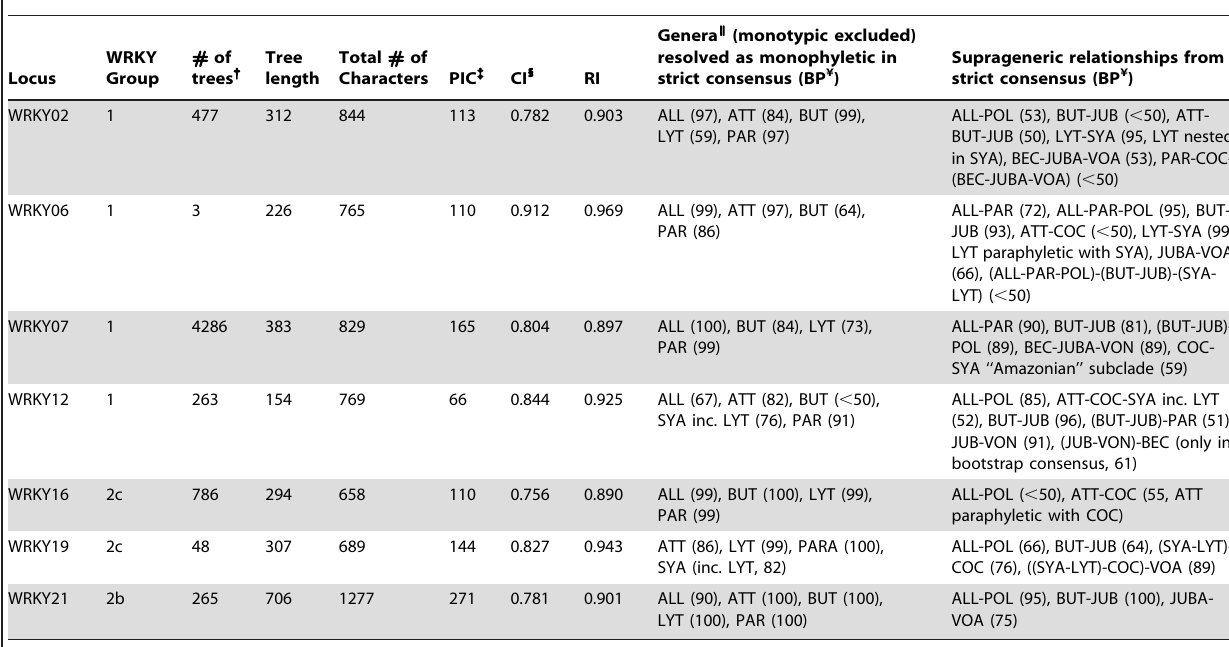
Table 1. Results of heuristic maximum parsimony phylogenetic analyses of seven WRKY loci across subtribe Attaleinae.